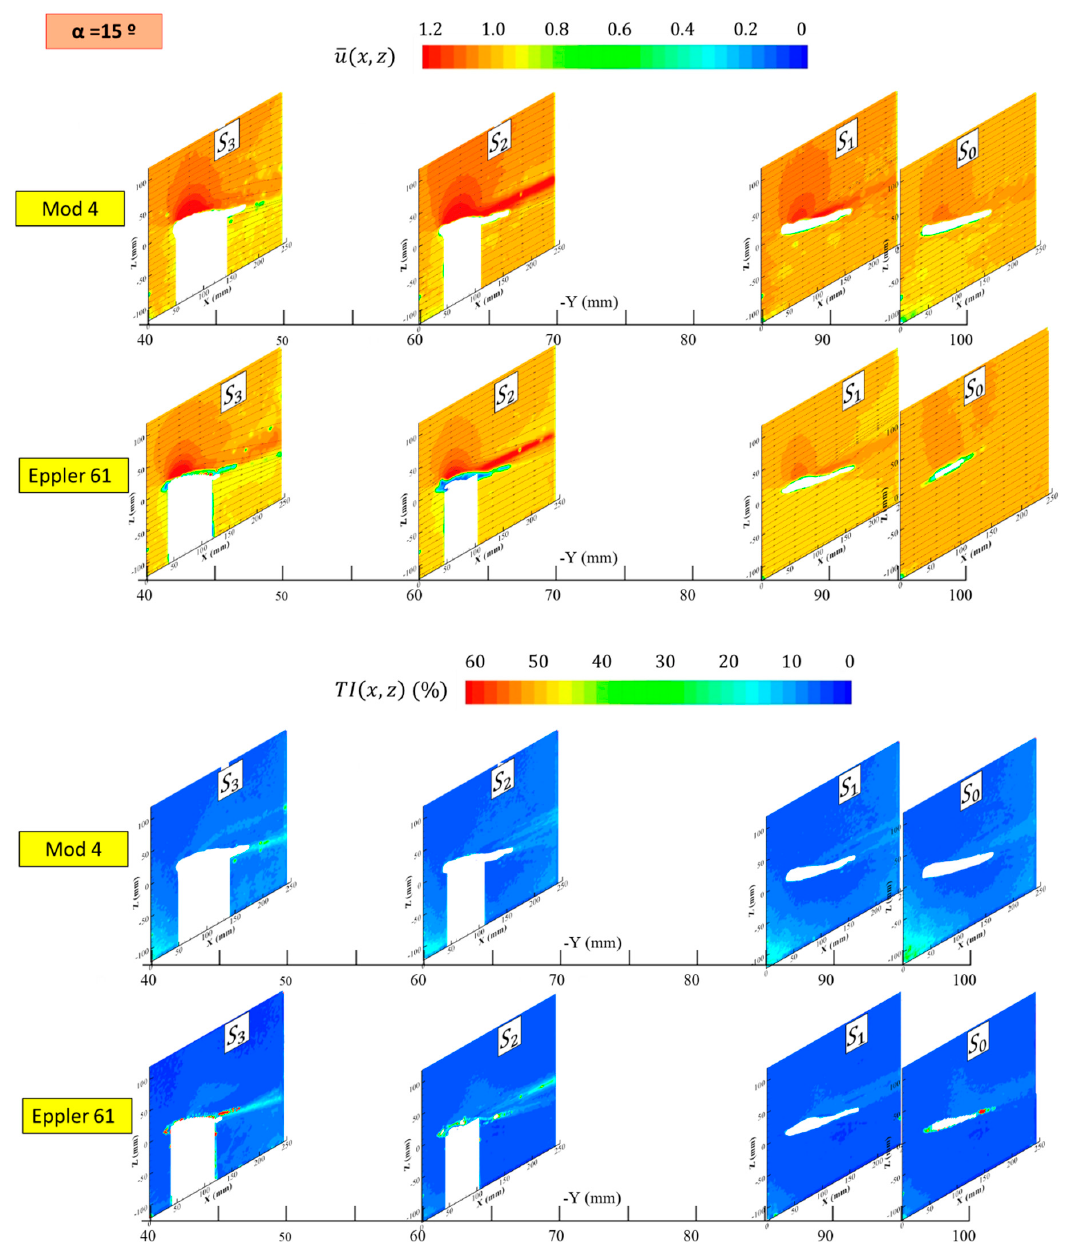
Figure 9. Non-dimensional velocity maps and turbulence intensity maps for each section at an angle of attack of 15°.